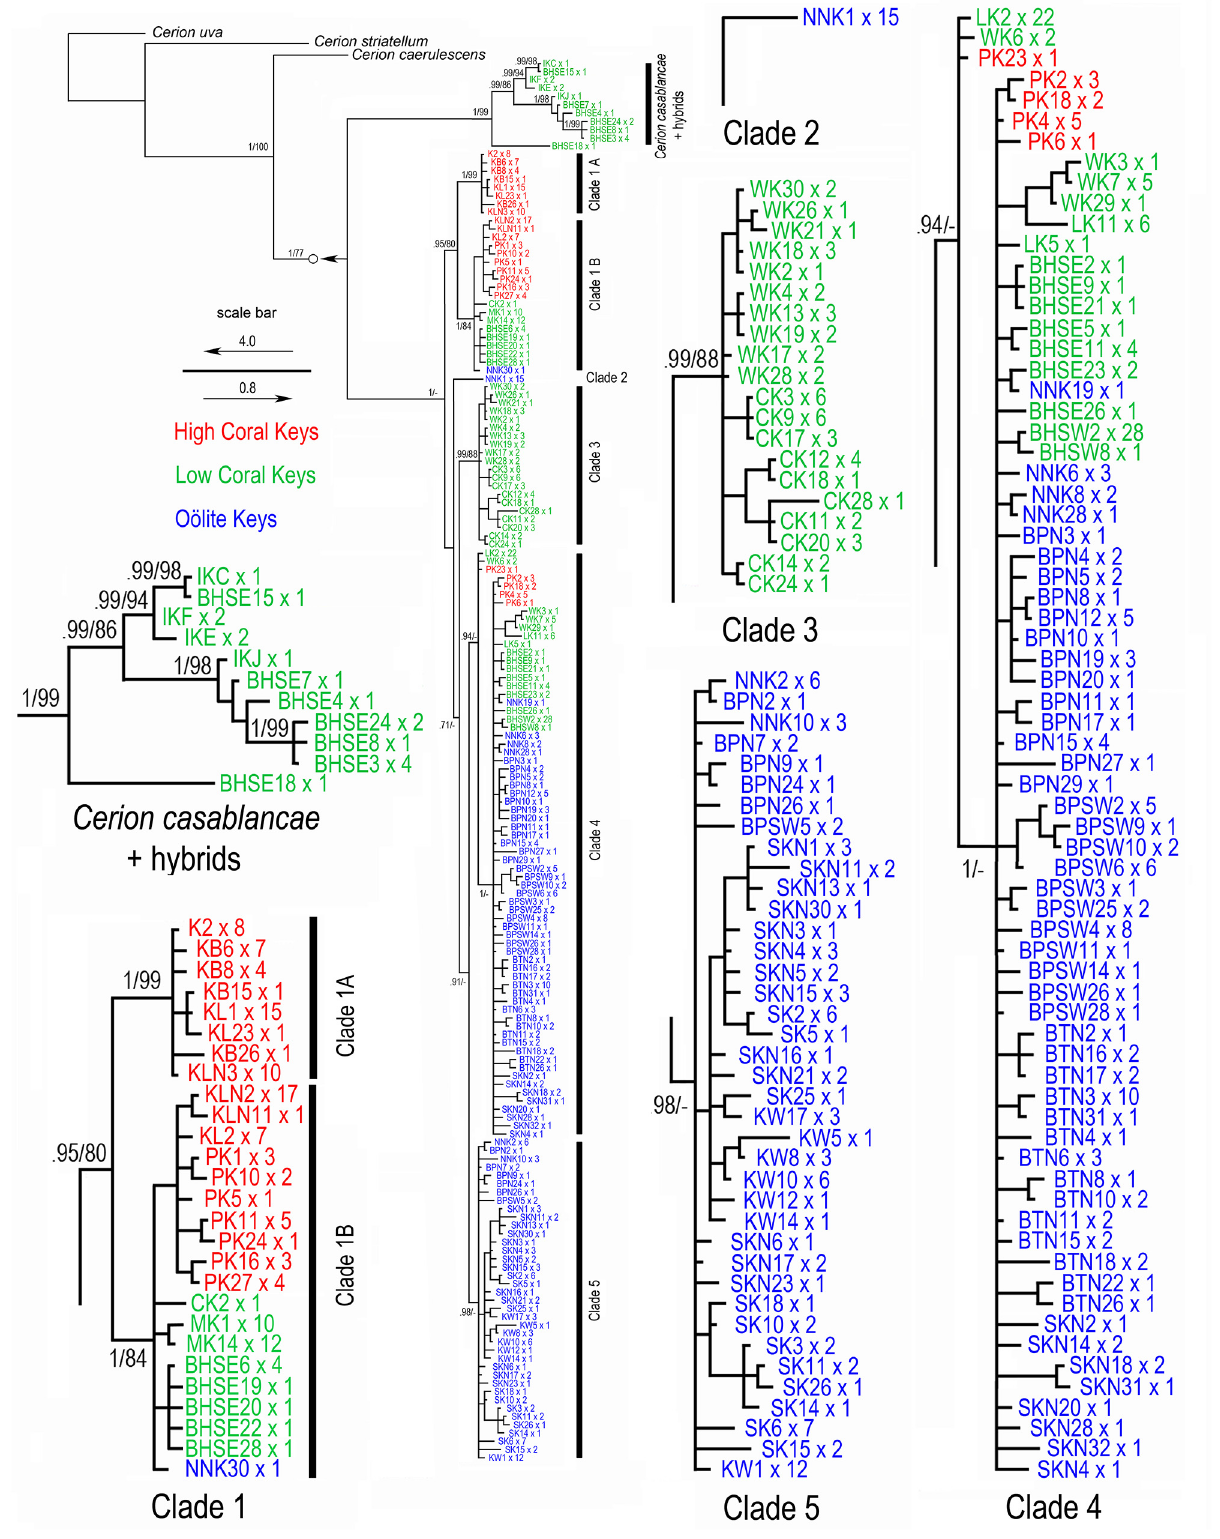
Fig 4. Phylogenetic relationships among the Cerion of the Florida Keys. Result of Bayesian analysis of the concatenated data including 16S and COI sequences. Numbers on nodes indicate BI posterior probabilities and ML bootstrap values respectively. Geographic regions are color coded. doi:10.1371/journal.pone.0137325.g004 PLOS ONE | DOI:10.1371/journal.pone.0137325 September 17,